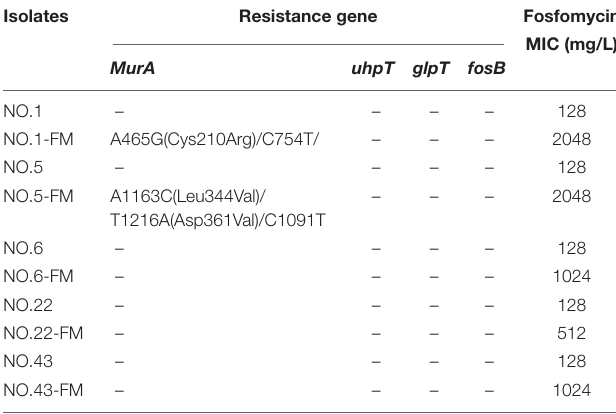
TABLE 4 | MIC values of fosfomycin and resistance mechanisms in fosfomycin resistant-mutants obtained from the fosfomycin MPC study.